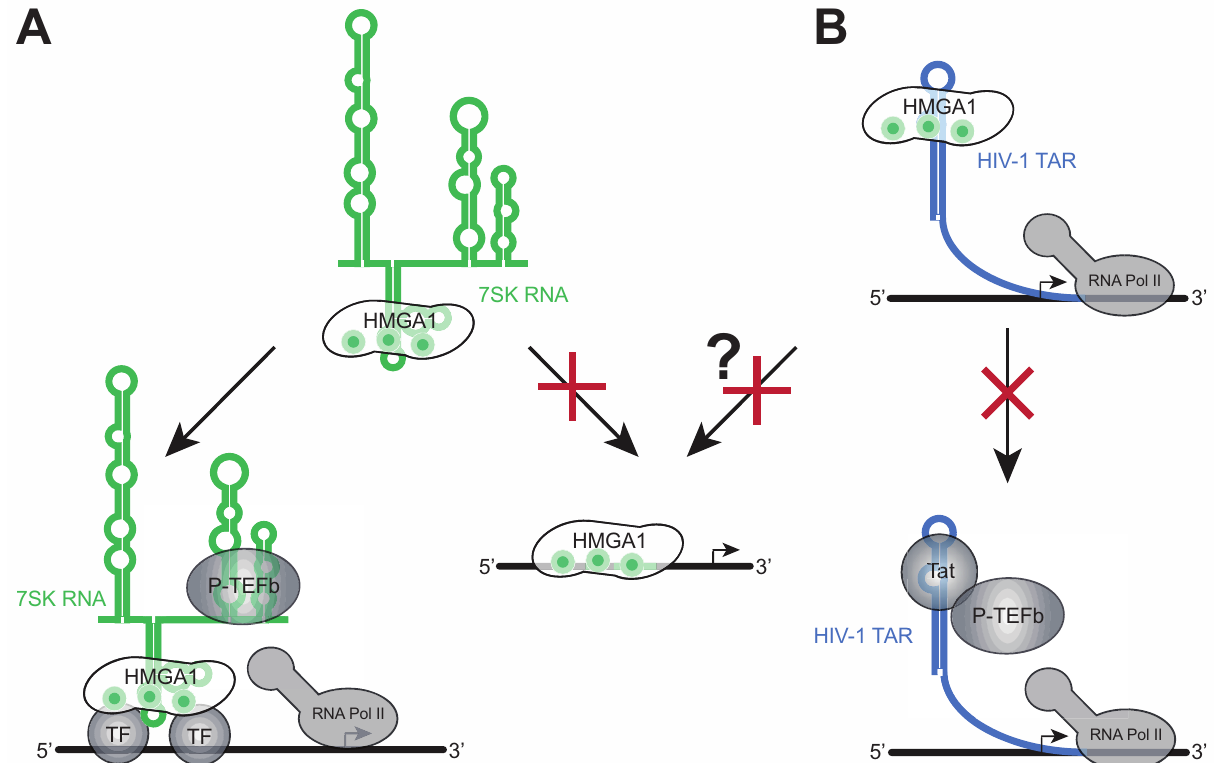
Figure 3. Cellular functions of HMGA1-RNA complexes. ( A ) HMGA1 is involved in the recruitment of 7SK-inactivated P-TEFb to the HIV-1 and cellular core promoters. 7SK RNA acts as a negative regulator of HMGA1 DNA-binding, subsequently regulating HMGA1 target gene expression; ( B ) The HMGA1/TAR interaction prevents Tat/TAR binding. HIV-1 TAR might also negatively regulate HMGA1-dependent gene